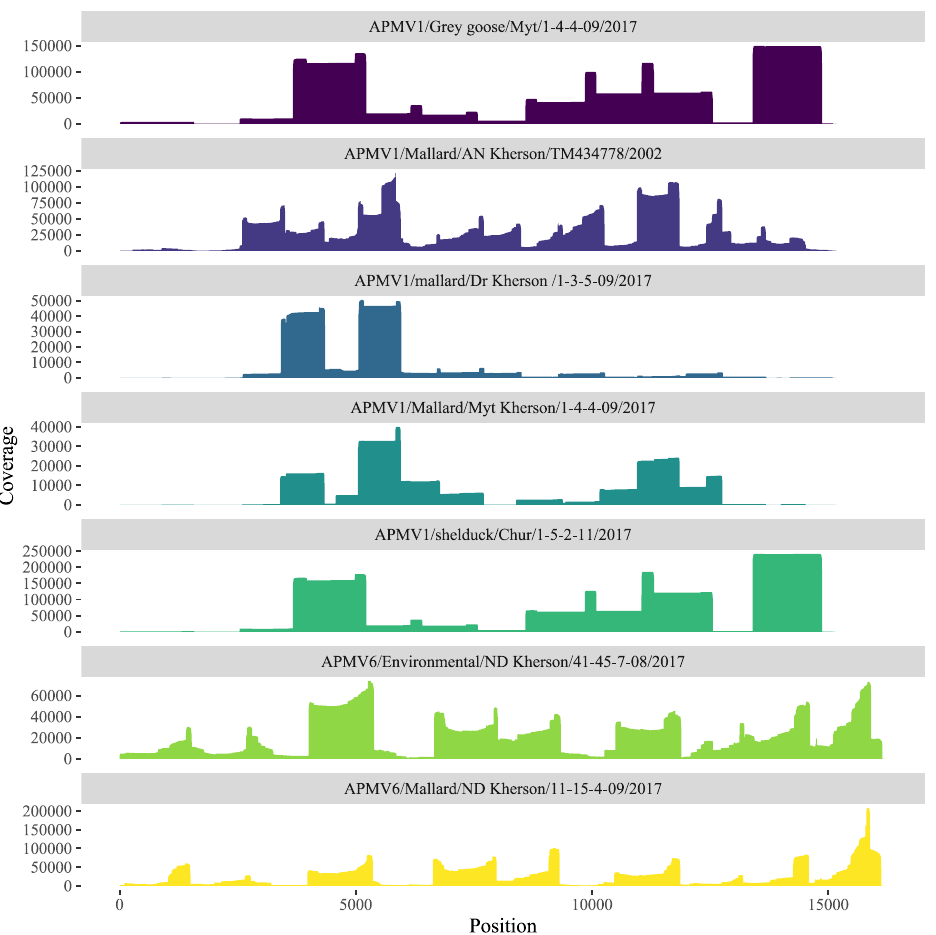
Figure 2. Sequencing coverage depth across full-length genomes for the seven APMV samples sequenced in this study. Viral RNA was amplified by RT-PCR with a panel of tiling primers covering the whole genome, and cDNA amplicons were sequenced using MinION. Reads were mapped to a reference, and coverage depth was calculated with the bedtools genomic arithmetic package.